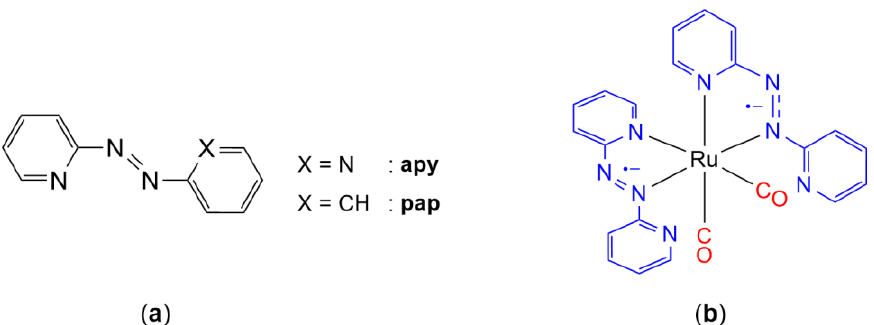
Figure 1 Figure 1. Chemical structures of ( a ) azopyridines; ( b ) The Ru-complex presented in this